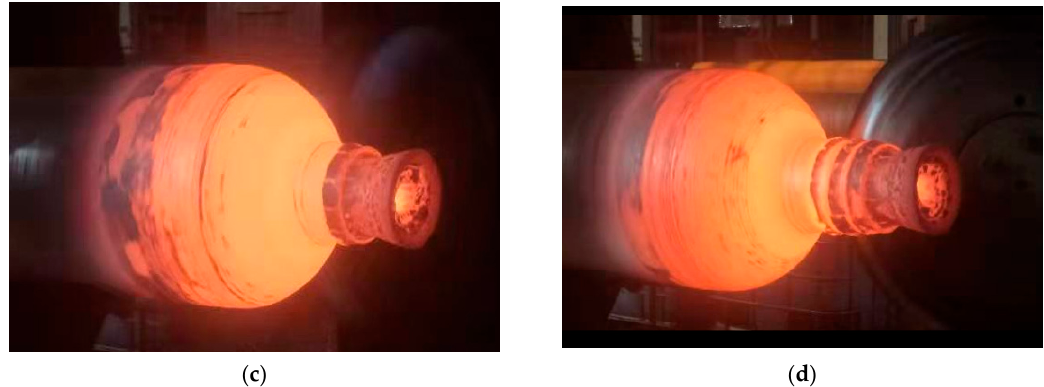
Figure 8. Spinning forming experiment process. ( a ) Spinning process 1. ( b ) Spinning process 2. ( c ) Spinning process 3. ( d ) Spinning process 4.